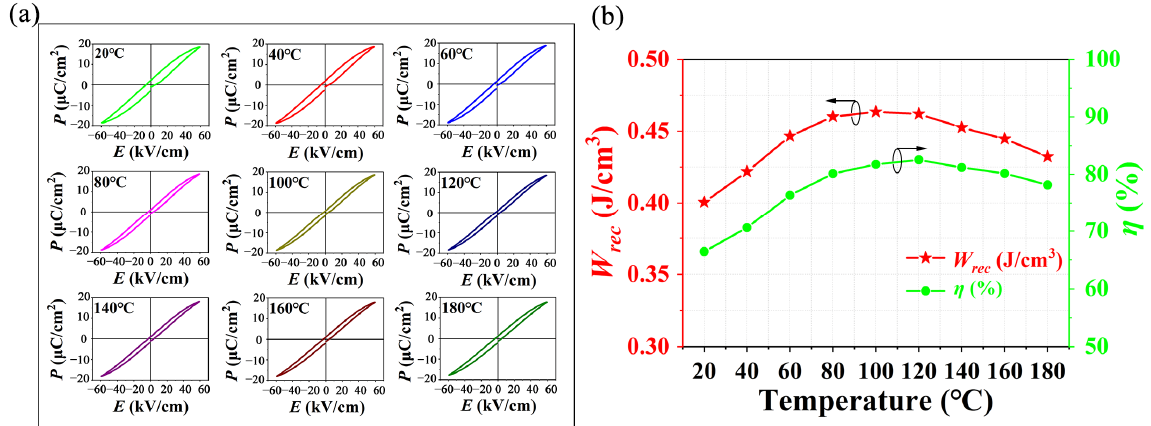
Figure 9. ( a ) P-E loops of NBT-BT-NN ceramic which were measured at different test temperatures. ( b ) Temperature dependence of W rec and η of NBT-BT-NN ceramic. ( b ) Temperature dependence of W rec and η of NBT-BT-NN